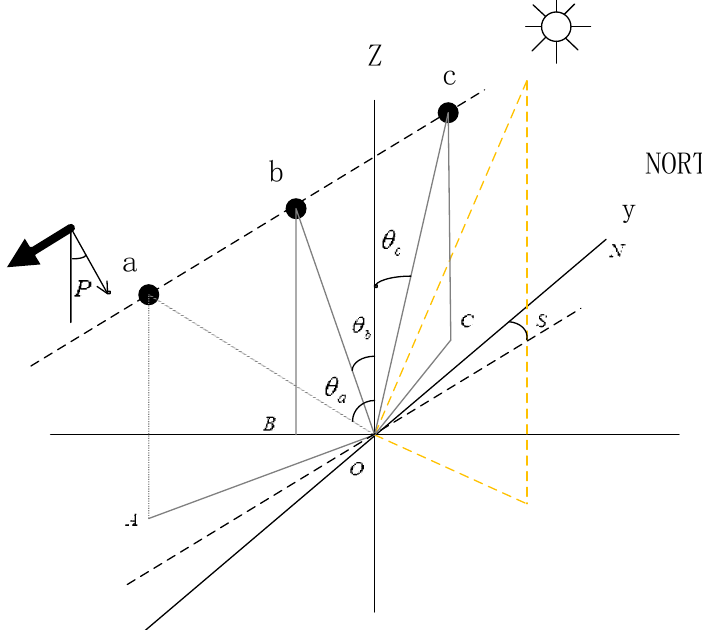
Figure 1. Observational geometry of the Advanced Spaceborne Thermal Emission and Reflection Radiometer (ASTER) stereo images (after Yang et al. [11]). Sun zenith angle ( θ 0 ), sensor nadir-looking viewing angle ( θ b ), sensor forward-looking viewing angle ( θ c ), sensor backward-looking viewing angle ( θ a ), scene orientation angle ( S ), and pointing angle ( P ) is presented.